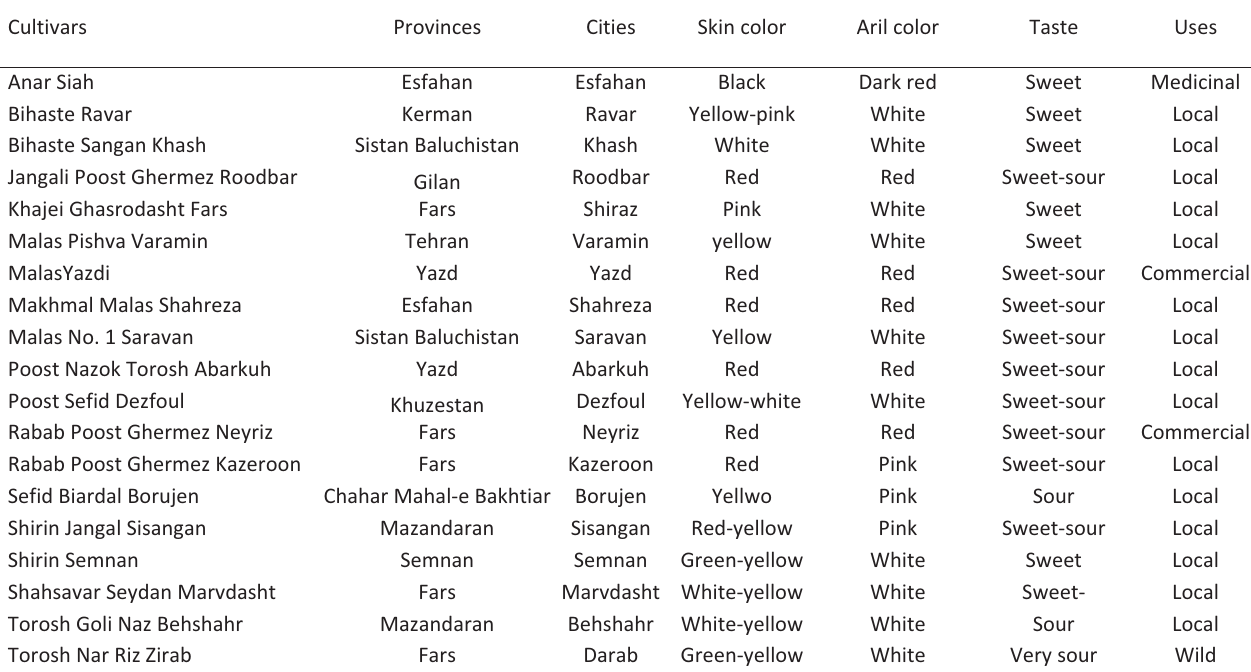
Table 1 ­ Name, origin, fruit and tree characteristics of pomegranate cultivars used in this study